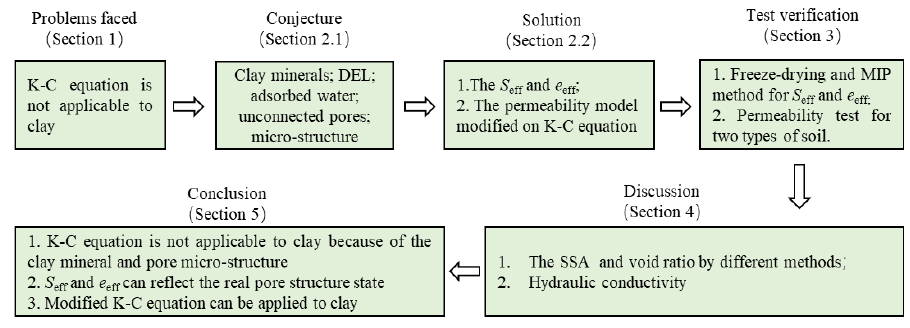
Figure A1. Research ideas of this paper.